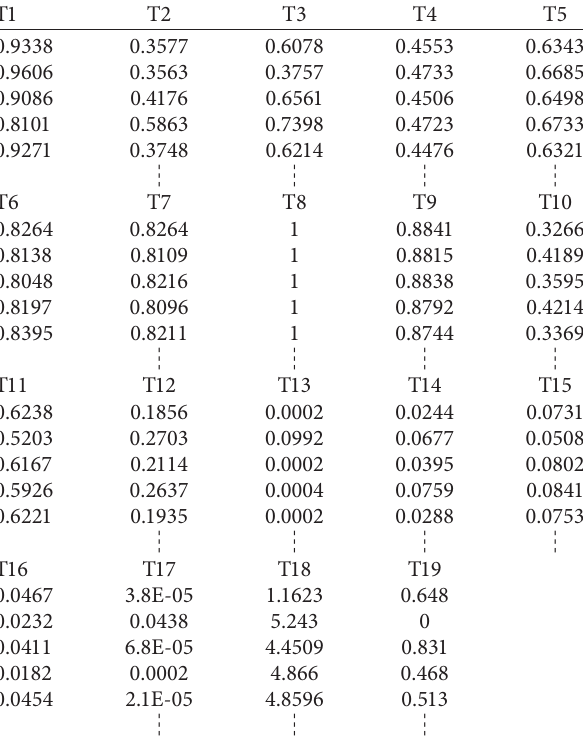
Table 1: Extraction results of mixed feature parameters of vehicle targets from some testing samples.